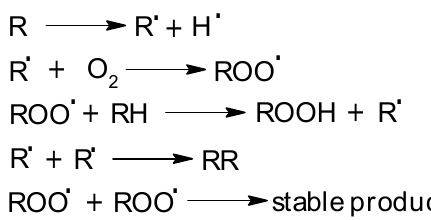
Figure 1. Main radical steps of autoxidation of lipids and biodiesel. This decomposition produces the known aging products of biodiesel, namely car- boxylic acids, aldehydes, ketones, etc. [17]. The key factor for stability of the fuel is how fast the aging proceeds. Therefore, the kinetics of aging and the associated sequence of the formation of aging products is crucial. The formation of the aging products and the associated reactivity of these components leads to increased aging behavior of the fuel. To increase the stability of the fuel, the radical aging mechanism is slowed down with the help of antioxidants (radical scavengers) [18]. Therefore, commercial radical scavengers, such as tert-butylhydroquinones (TBHQ), are used as additives in biodiesel [19]. In addition, other molecules, such as solketal, showed oligomerization-inhibiting behavior, although they are not applied as antioxidants [20]. Gel permeation chromatography (GPC) measure- ments showed that fewer higher molecular weight molecules are formed in the presence of solketal. The preparation of solketal is shown in Figure 2.